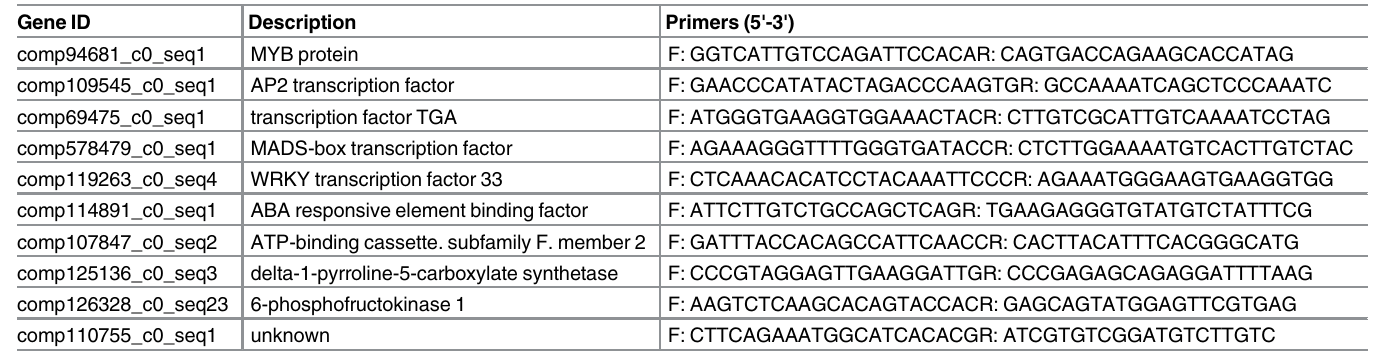
Table 1. Primers of qRT-PCR for validation of the selected